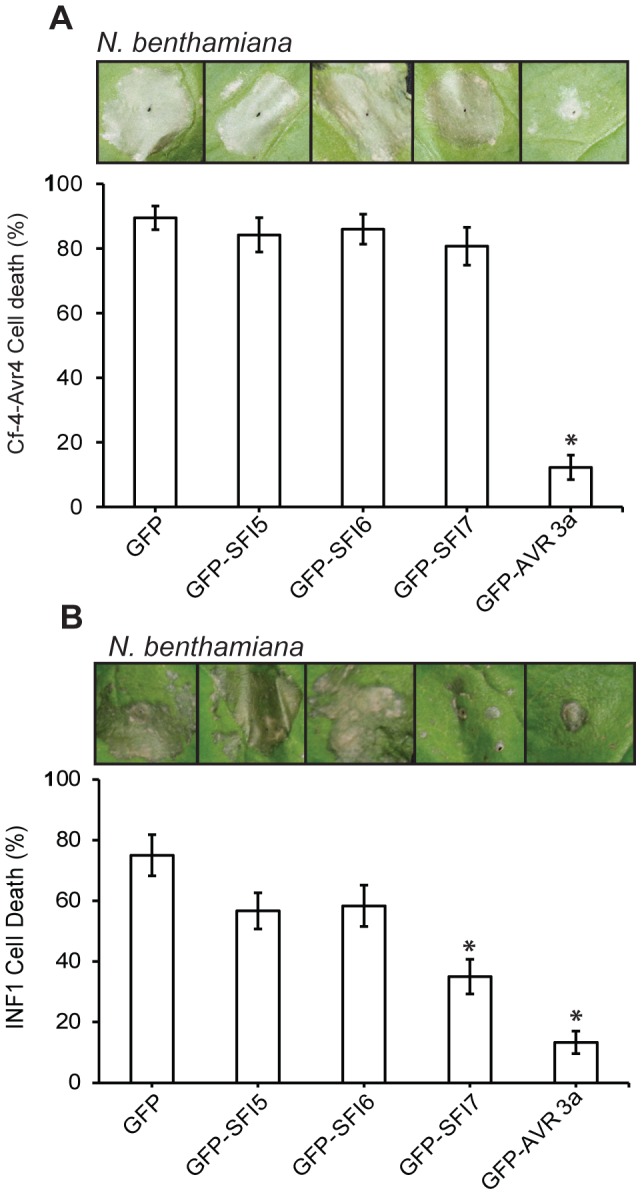
Effect of GFP-SFI5, GFP-SFI6 and GFP-SFI7 on PCD triggered by INF1 or by co-expression of Cf-4 with Cladosporium fulvum Avr4.(A) Percentage of inoculation sites showing confluent cell death at 7 days post-infiltration of Agrobacterium strains expressing each GFP-effector fusion protein with a strain expressing Cf-4 and Avr4. (B) Percentage of inoculation sites showing confluent cell death at 7 days post-infiltration of Agrobacterium strains expressing each GFP-effector fusion protein with a strain expressing INF1. Results in (A) and (B) represent five biological replicates, each involving 18 inoculation sites. Error bars represent SEM. * represents statistical significance (p<0.01) using one-way ANOVA.